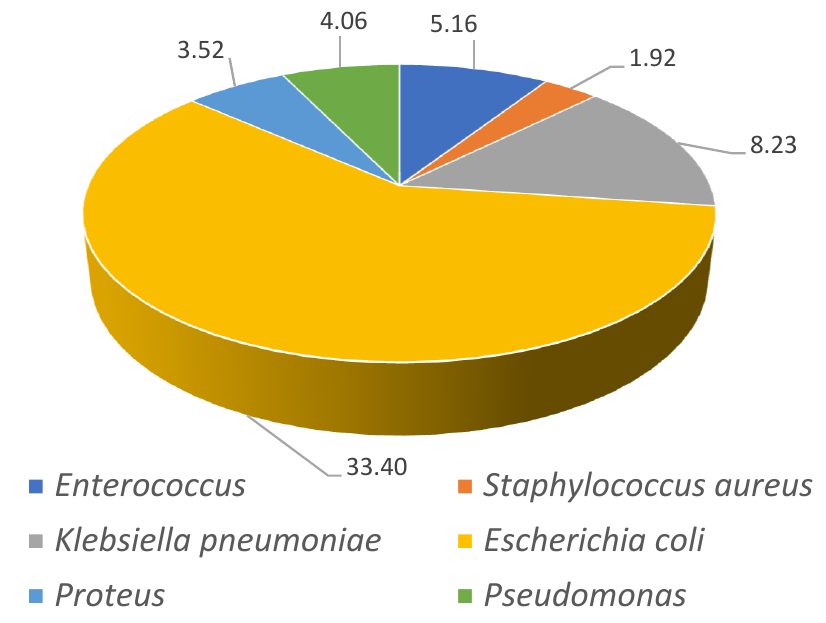
Figure 3. Prevalence of isolated pathogens for the last time period analyzed (2016–2018).